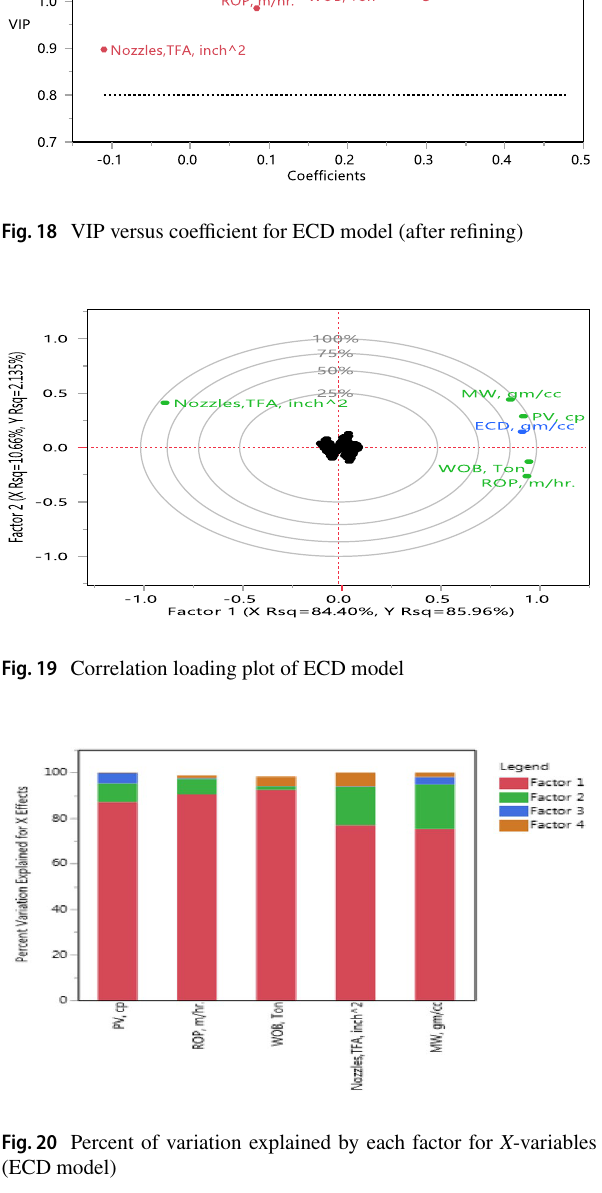
Fig. 23 Tornado chart for ECD